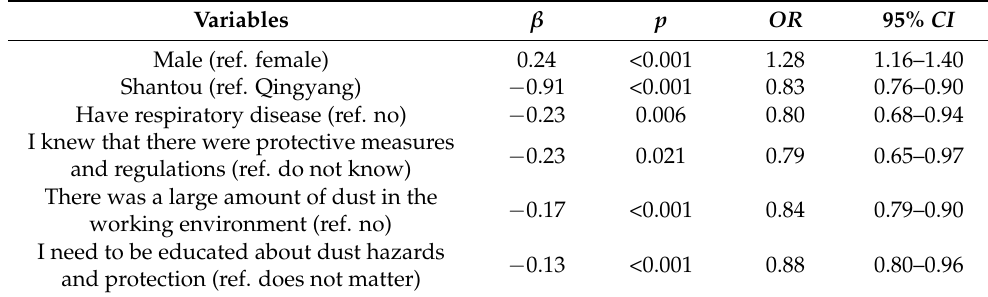
Table 4. Factors related to respiratory protection level for migrant interior construction workers (95% Confidence